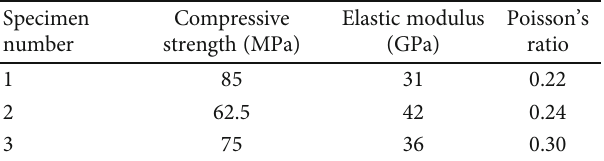
Table 3: Results of the uniaxial compression